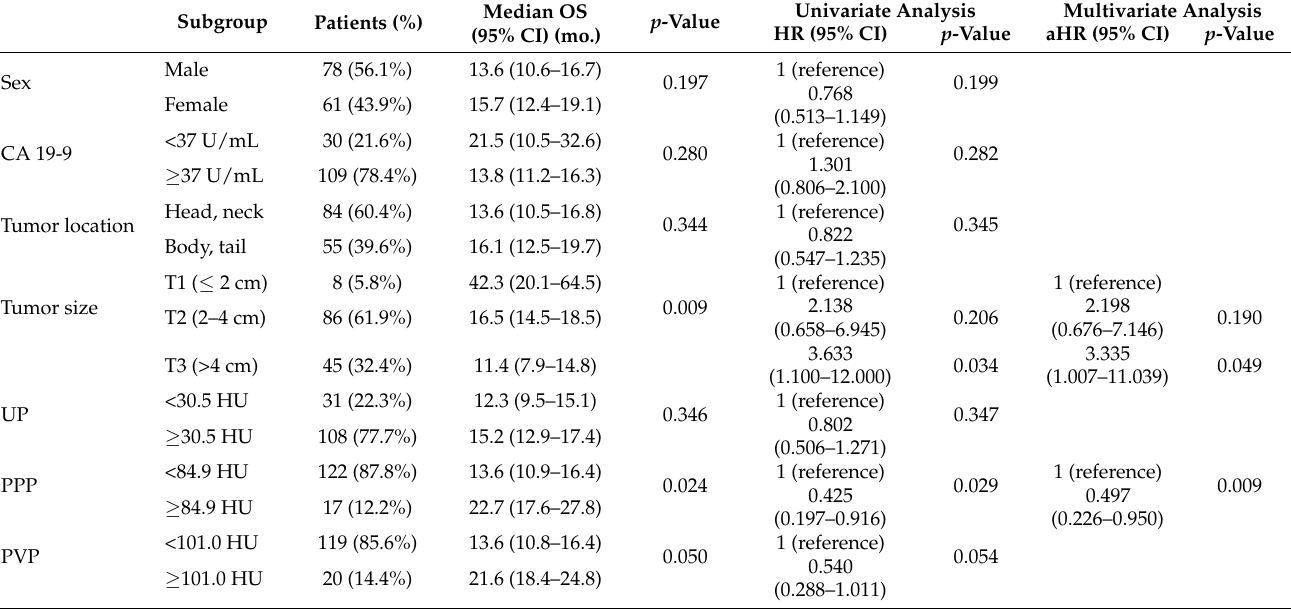
Table 4. Univariate and multivariate Cox hazard regression analysis of clinical and radiologic parameters in patients with borderline resectable or locally advanced pancreatic cancer on initial CT scan ( n =